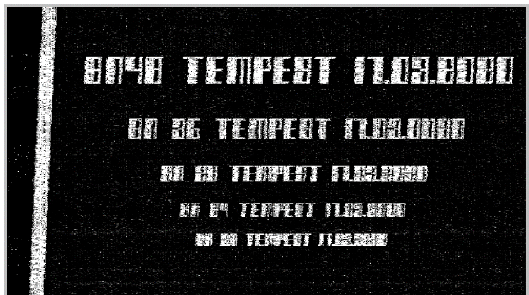
Figure 14. Image recovered when secure asymmetrical font with upper case letters—without reverse video option enable.